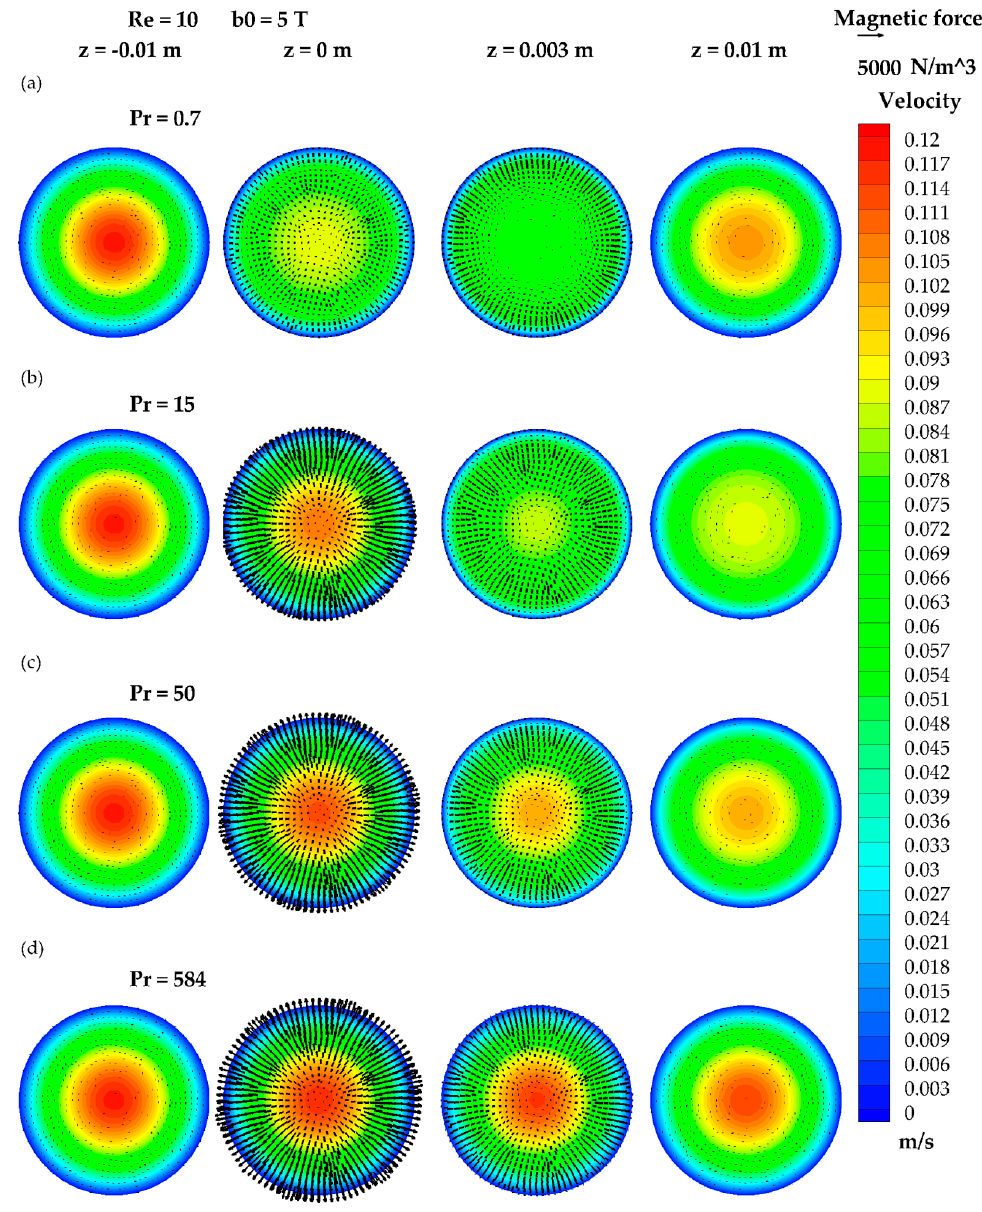
Figure 13. Flow structure in the radial cross-sections ( z = − 0.01 m, 0 m, 0.003 m, 0.01 m) at Re = 10 and b 0 = 5 T: ( a ) Pr = 0.001, ( b ) Pr = 15, ( c ) Pr = 50, ( d ) Pr = 584.